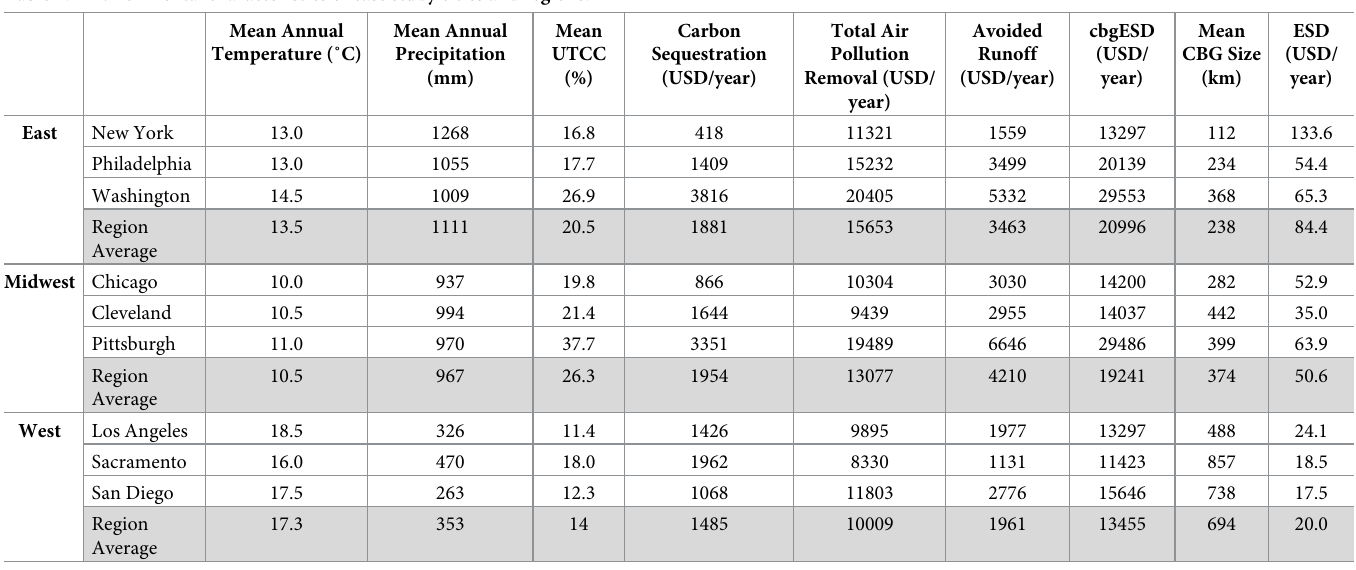
Table 4. Environmental characteristics of case study cities and regions.